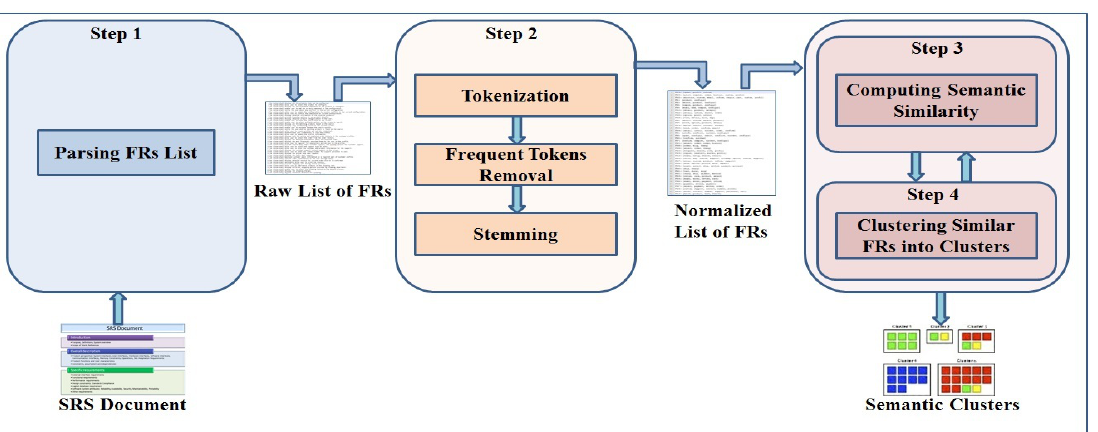
Figure 2. The proposed approach